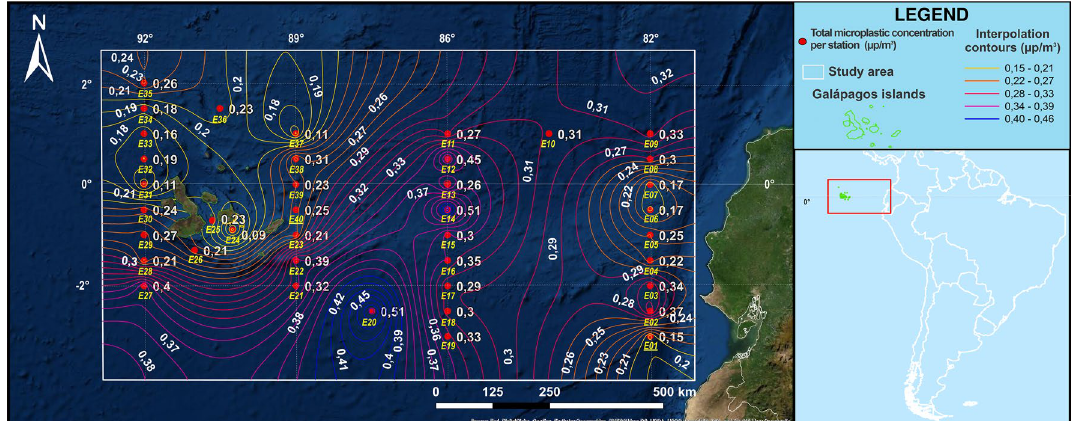
Figure 1. Spatial interpolation of the microplastic particle concentrations in the study area. Using the known values of microplastic particles concentrations determined (µp/m 3 ), combining both 150 and 500 µm-plankton nets at the precise oceanic stations, estimate concentration values are determined at the remaining unknown spatial points. The Southeast and Northwest presented the lowest microplastics concentration, which was coloured in blue. The highest microplastic concentration was observed in international waters in the central to southern part of the study area coloured in red, potentially associated with ocean circulation patterns.